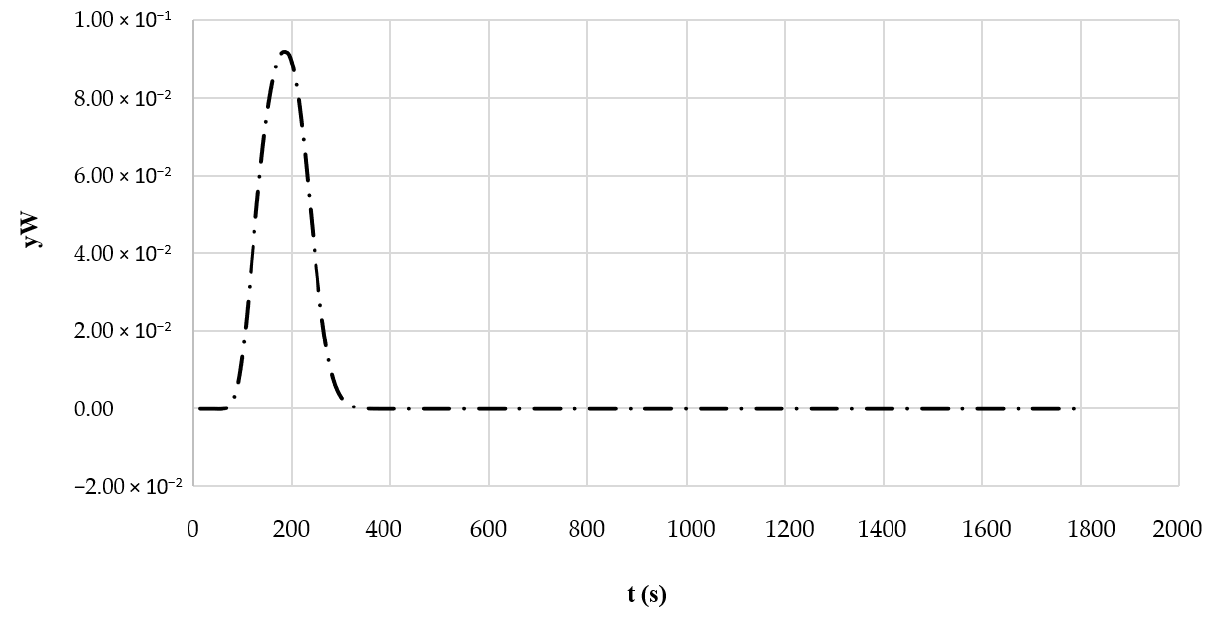
Figure 12. Water mole fraction in the output stream in the desorption step with time.